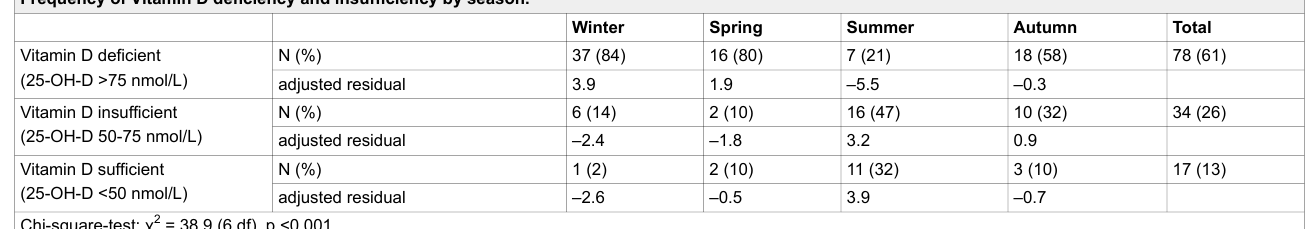
Table 3 Frequency of Vitamin D deficiency and insufficiency by